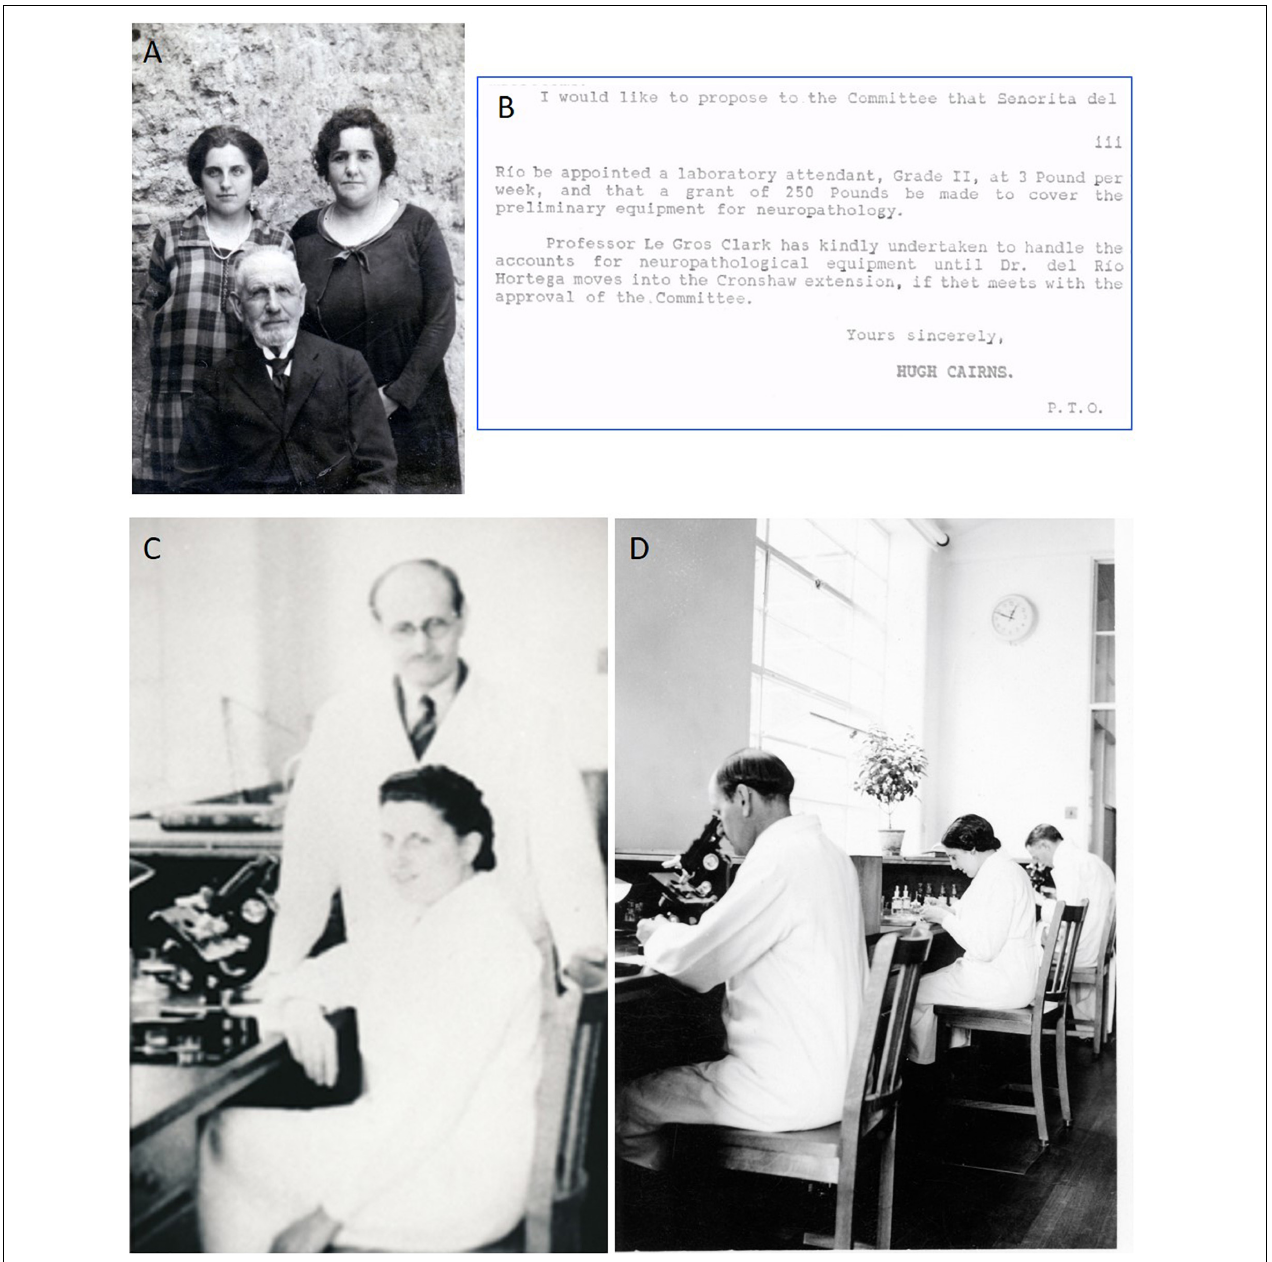
FIGURE 1 | Asunción Amo del Río. (A) Young Asunción Amo del Río (on the left) with her mother and her grandfather Juan at Portillo (Valladolid). (B) Detail of the report by Hugh Cairns (see the signature, below) to the Nuffield Committee proposing the appointment of “Senorita [ sic ] Del Río” as laboratory attendant of Pío del Río-Hortega. (C) Río-Hortega (on feet) and his niece and attendant, Asunción Amo del Río, at the laboratory of Neuropathology of the Nuffield Department, University of Oxford. (D) Dr. Pío del Río-Hortega (on the left), Asunción Amo del Río (in the middle), and Dr. William Gibson (on the right) developing their work in Neuropathology at the Nuffield Department, in Oxford,